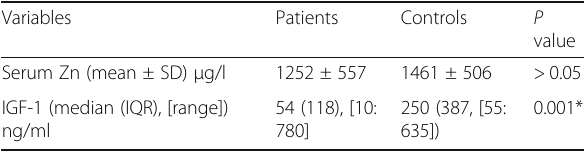
Table 2 Comparison between serum Zn and IGF-1 before treatment in the cholestatic patients and control Variables